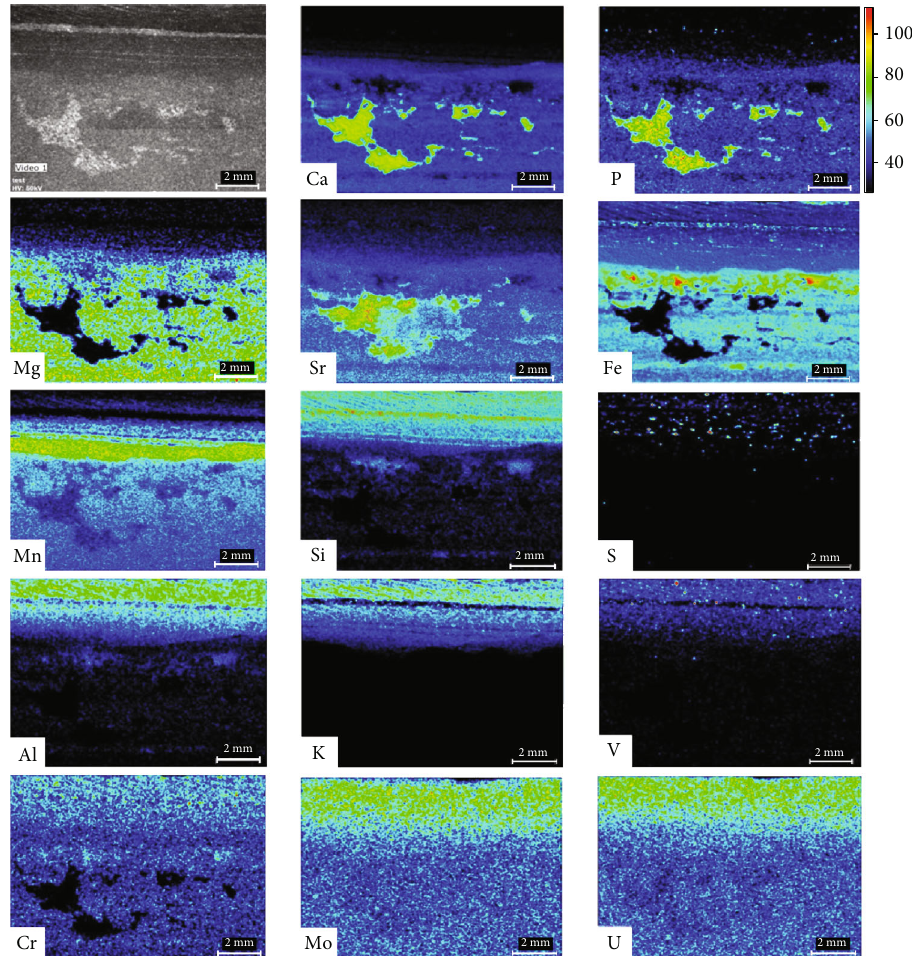
Figure 13: Multielement imaging of area D in Figure 1(d) by using XRF. Image size 11 : 9 × 9 : 77 mm ( 1190 × 977 pixels); 10 μ m pixel size; 4ms exposure time per pixel. All images share the same color